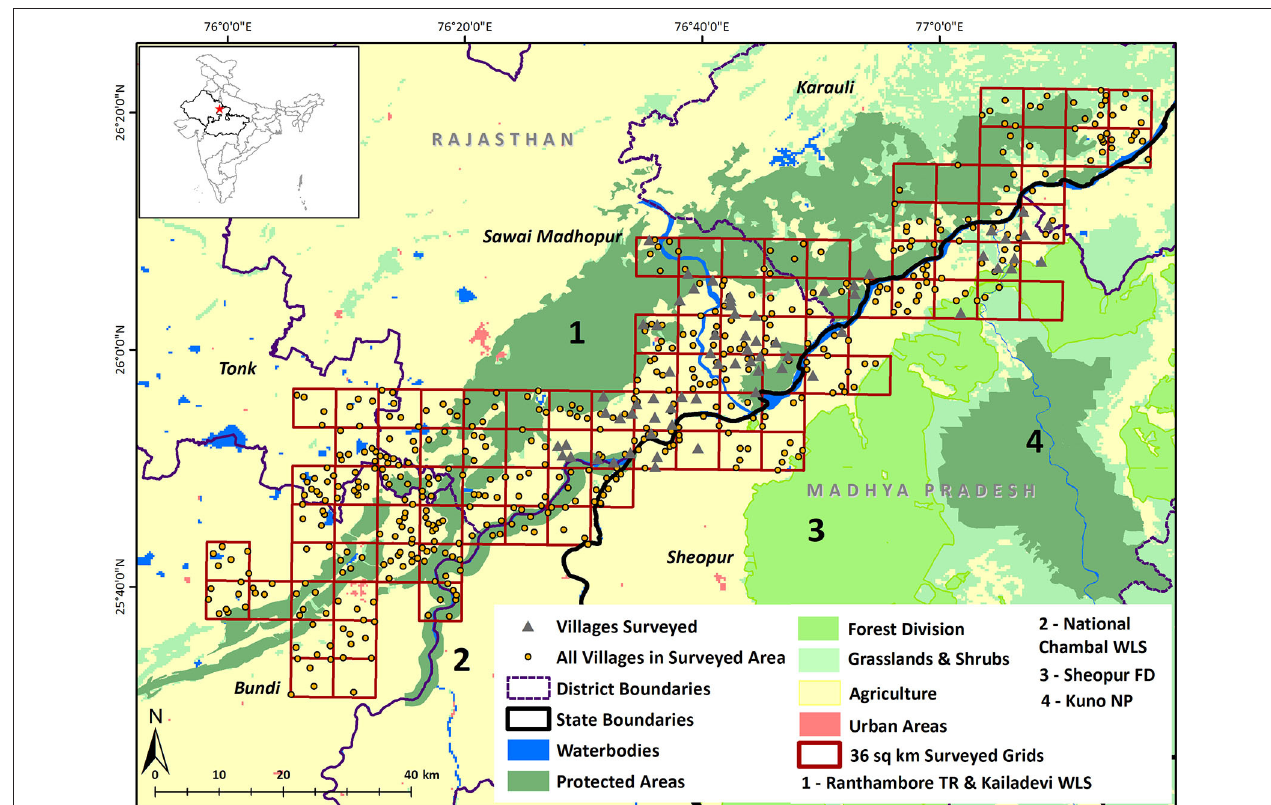
FIGURE 1 | The study landscape abuts the Ranthambore Tiger Reserve, and encompasses a multi-use landscape corridor that connects Ranthambore and Kuno National